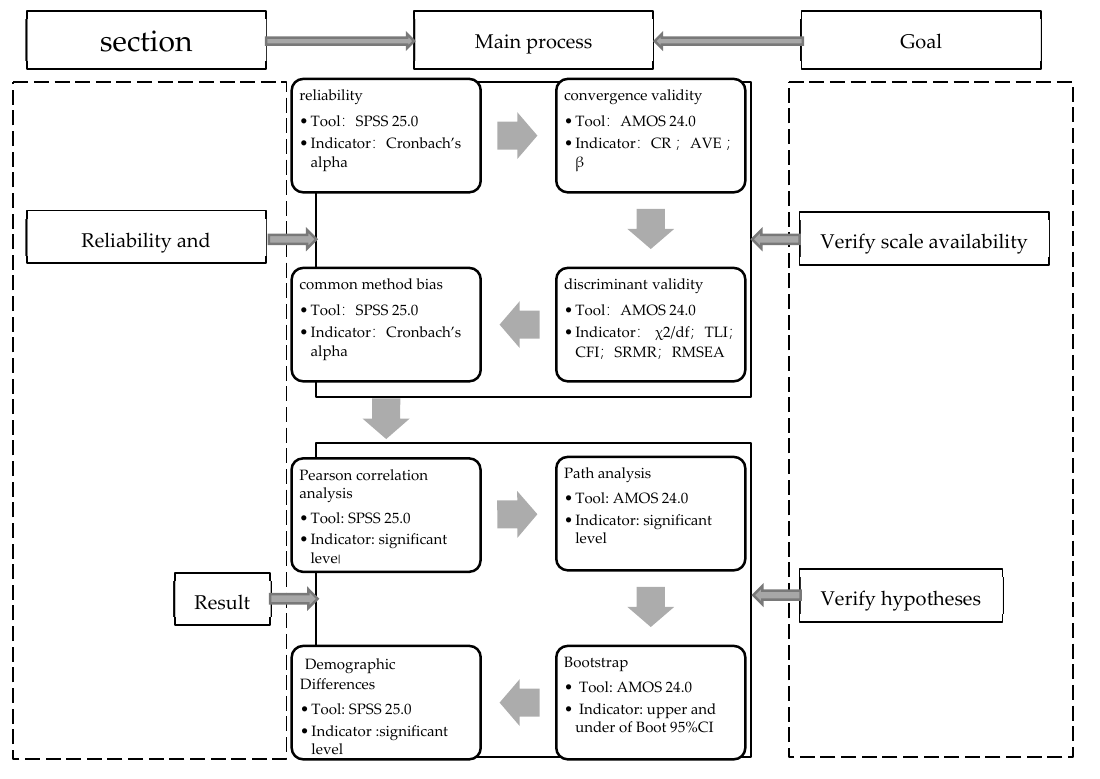
Figure 2. Data analysis flowchart.